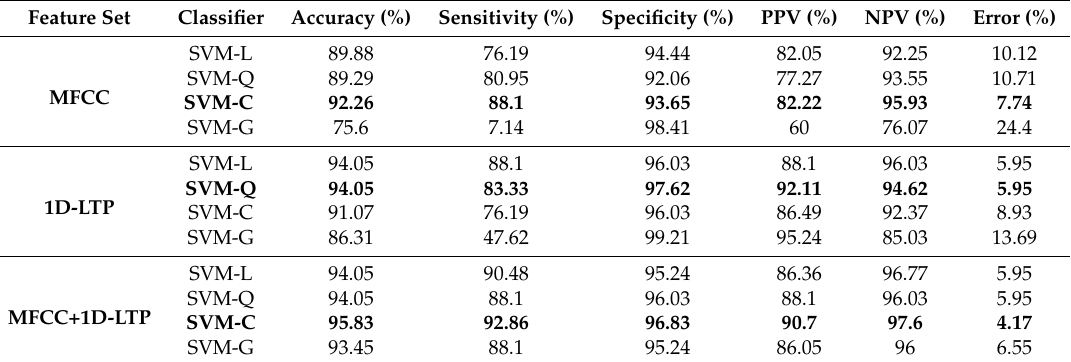
Table 4. Performance comparison of SVM on different feature sets for binary experiments. Bold font indicates the best result obtained against each feature set.